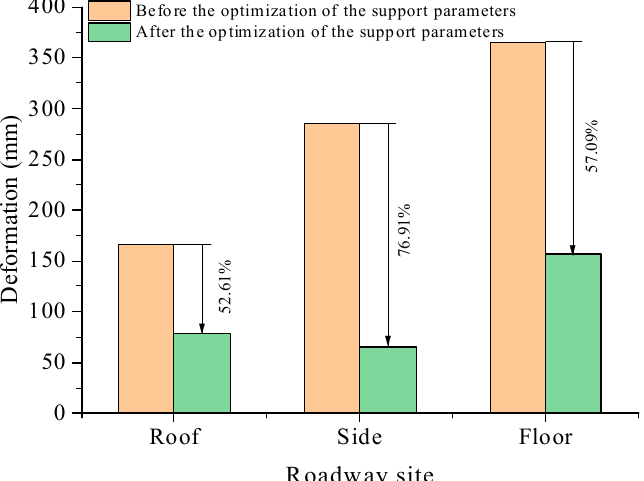
Figure 13. Fracture characteristics of the surrounding rock before and after optimization of support parameters. ( a ) Before the optimization of the support parameters; ( b ) after the optimization of the support parameters.